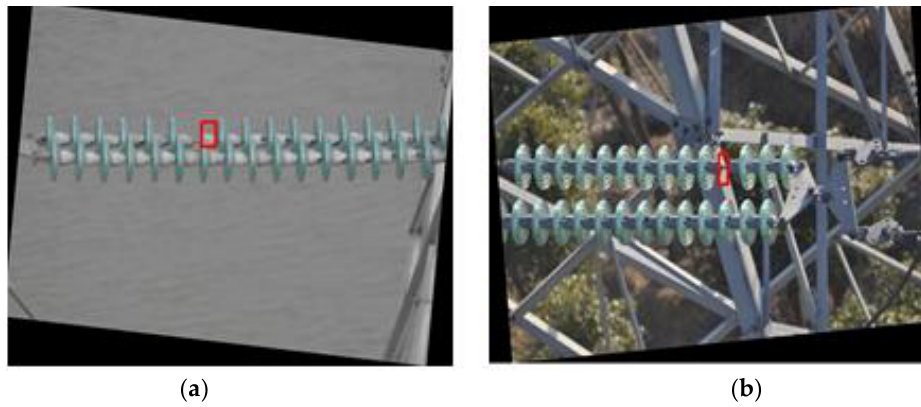
Figure 11. Results under different background complexities: ( a ) Simple background; ( b ) Complex background.